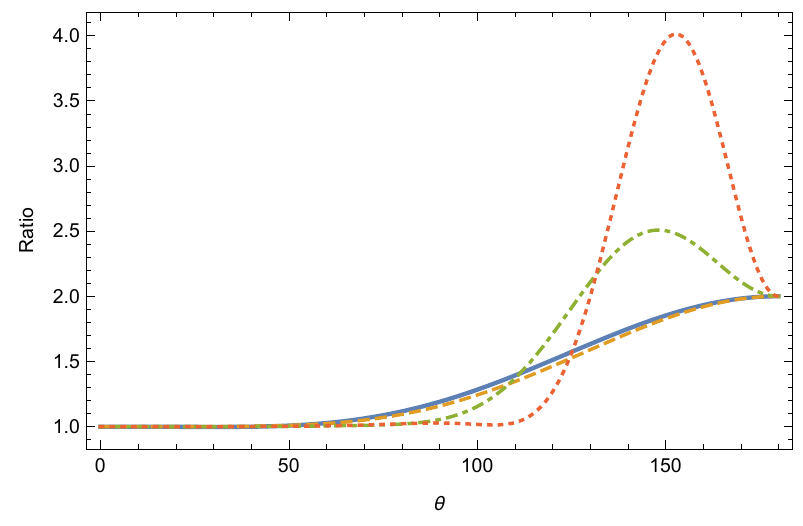
Figure 1. Plot of the functions R ( q , θ ) defined in Equation (3) for q = 1/2 (solid), q = 2 (dashed), q = 4 (dotdashed), and q = 6